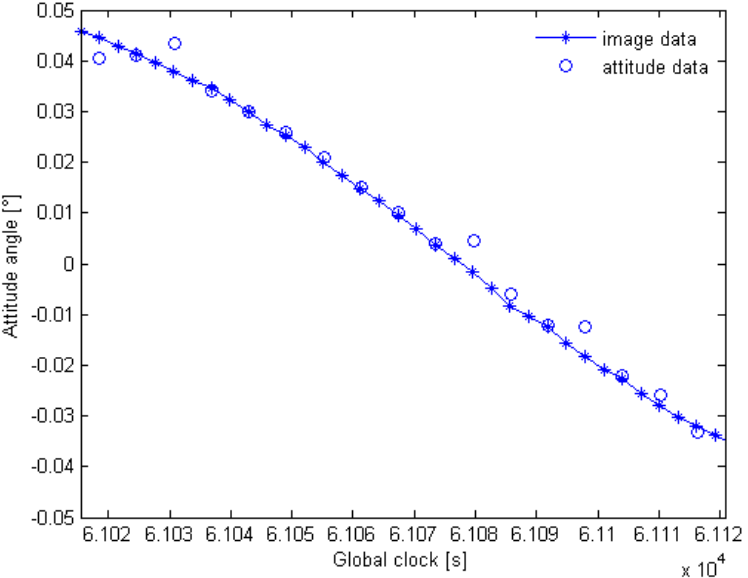
Figure 11. Distribution map of image acquisition data and attitude acquisition data.